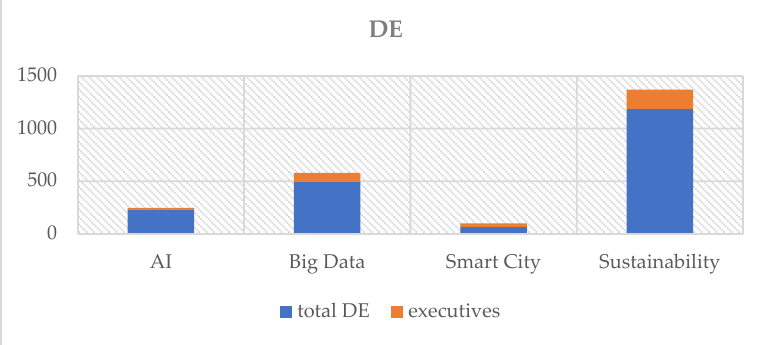
Figure 4. The number of job offers in the energy sector in Germany with selected skills required: the total number and the number of job posts for executives.